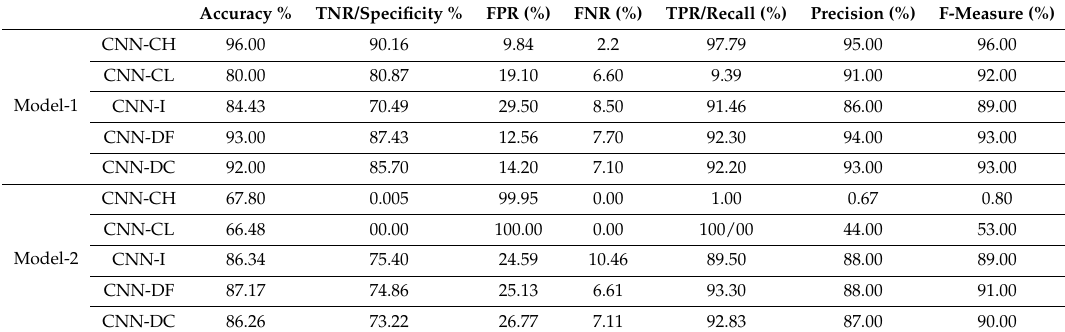
Table 6. Performance of various cases on 400 × dataset.